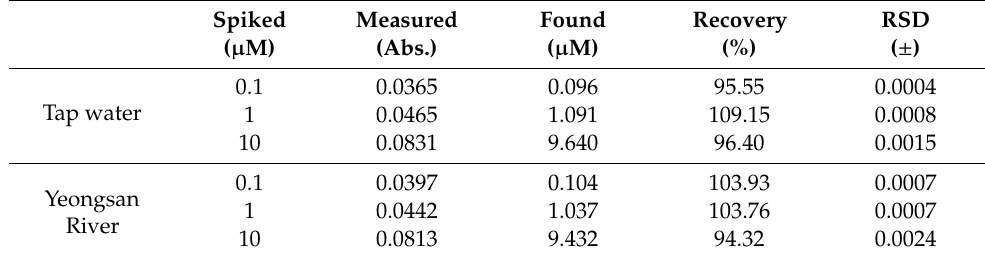
Table 1. Real sample test results obtained with the developed As 3 + sensor ( n =